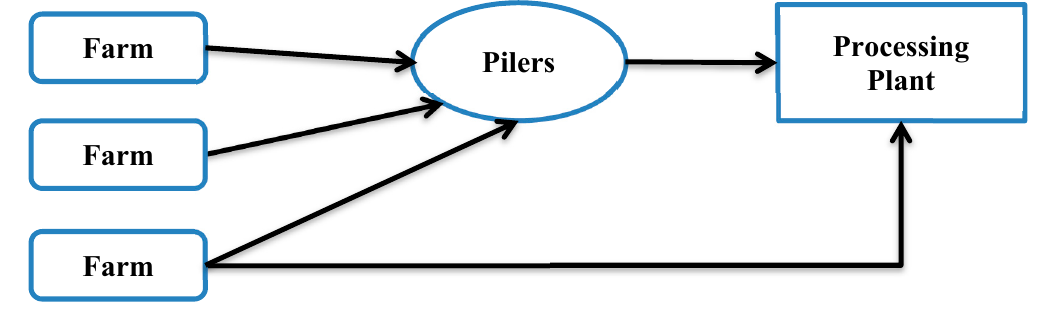
Figure 2. Sugar beet processing.